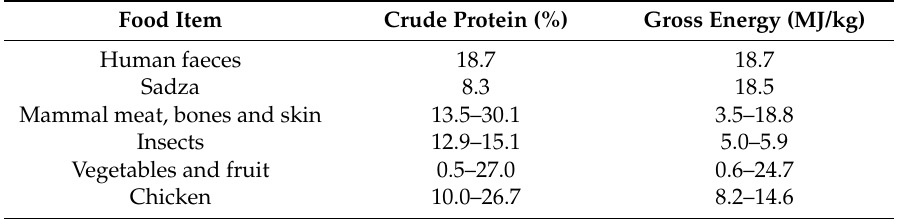
Table 2. The mean crude protein and gross energy content of human faeces and sadza, compared with ranges for the mammalian remains, insects, and vegetable and fruit species eaten by dogs (see Table 1) taken from studies of food in Zimbabwe [27].